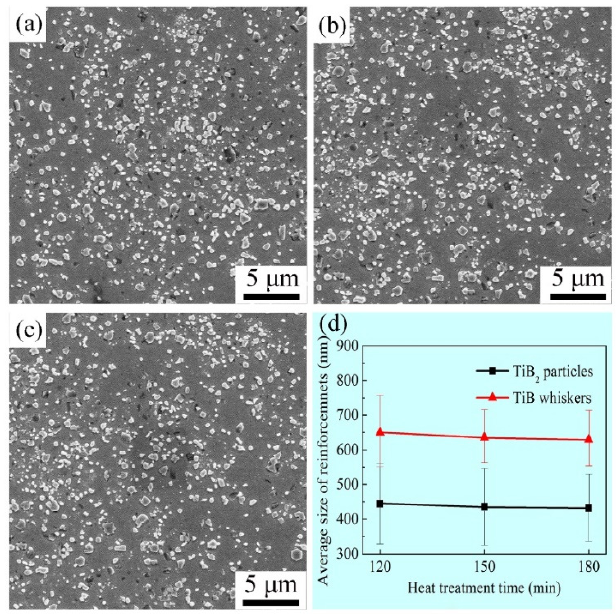
6 of 11 Figure 5. Viscosity–temperature curves of the molten Cu-B and Cu-Ti master alloys. 3.2. Effect of Heat Treatment Time on Microstructures and Properties of Composites 3.2.1. Microstructures of Composites In addition to controlling the degree of in situ reaction at liquid state by reaction temperature, as discussed in Section 3.2, the study carried out by Sobhani et al. [18] shows that heat treatment is also an effective method to optimize the properties of TiB 2 /Cu com- posites, i.e., the residual Ti and B in Cu matrix may further react at solid state during heat